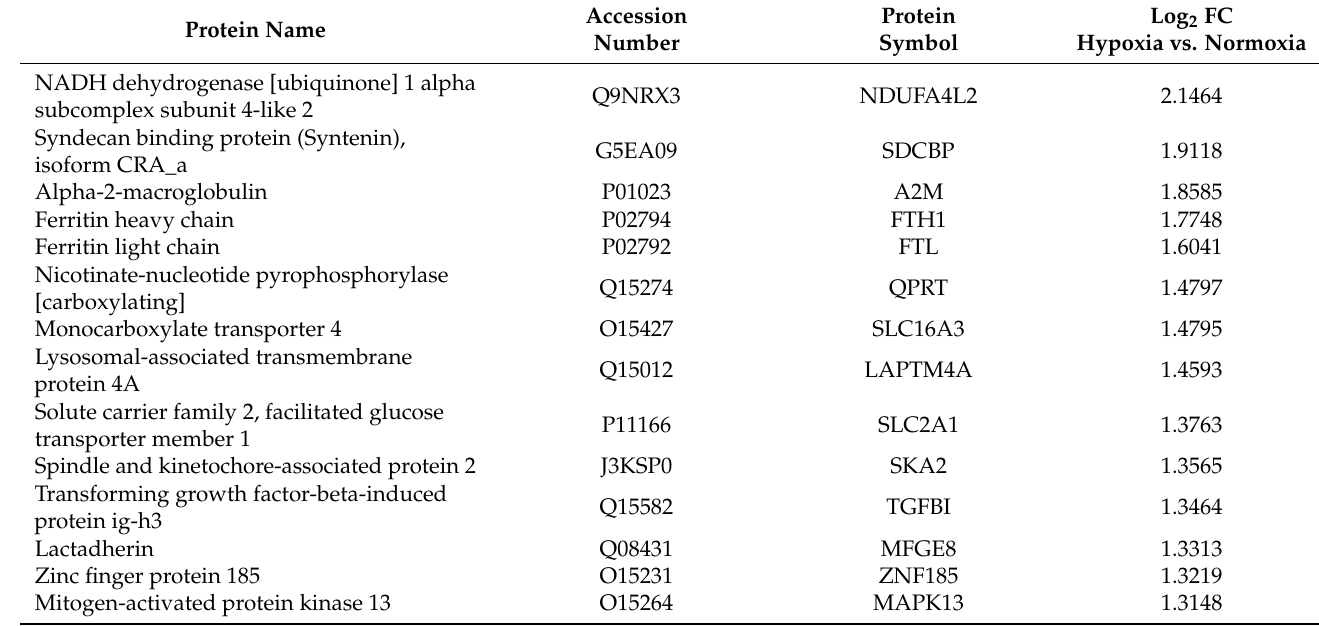
Table 2. Data on relative protein expression upregulation in hFPTs cultured in hypoxia conditions as compared to hFPTs cultured in normoxia conditions. Relative quantitative data were expressed as fold change logarithms (i.e., base 2 log), with a significance threshold value specified at 0.9 for upregulation and an FDR threshold value specified at ≤ 0.01. Data were ranked according to their respective log 2 FC values. Full datasets are available in Supplementary Materials, Spreadsheet S1. hFPTs, human fetal progenitor tenocytes; FC, fold change; FDR, false discovery